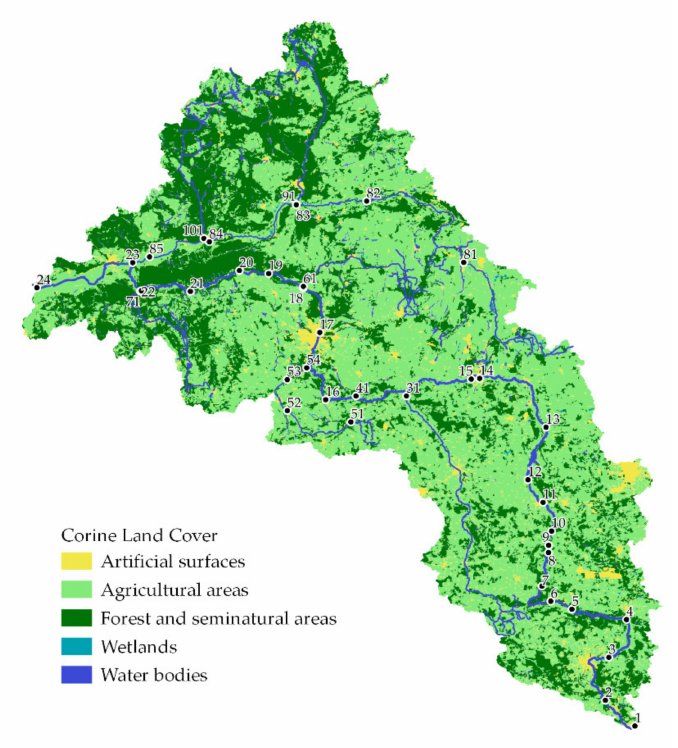
Figure 2. Land cover of the River Warta basin according to Corine Land